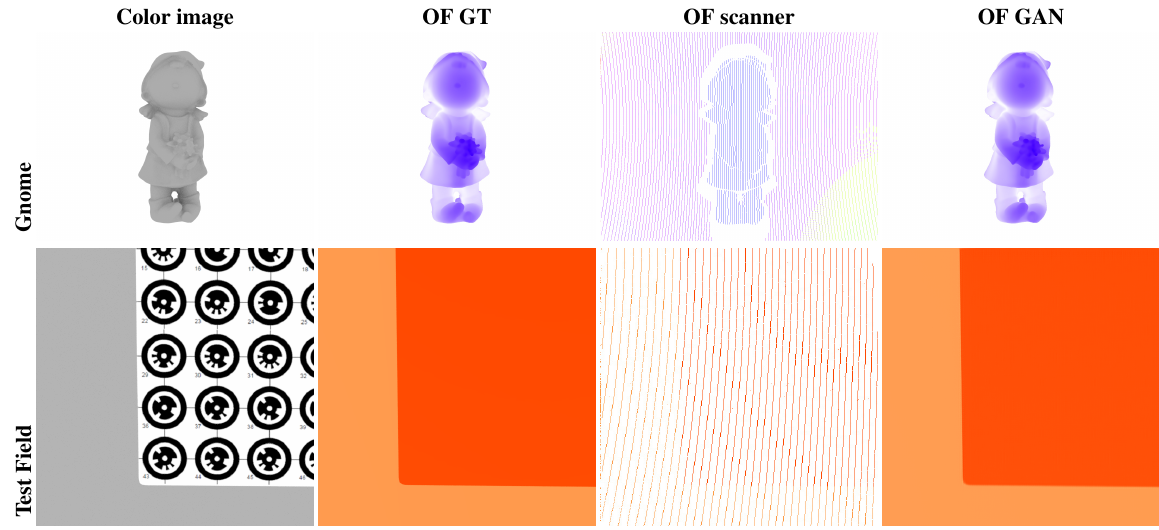
Figure 5. Qualitative evaluation